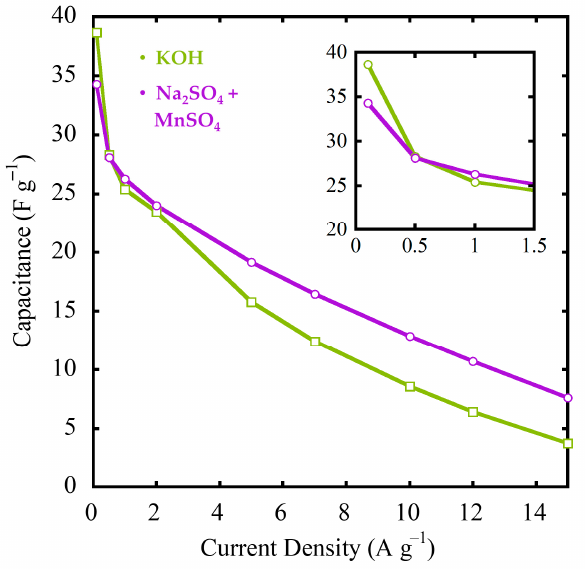
Figure 9. Comparison of the capacitances of the final systems calculated from GA charge/discharge curves shown at Figure 7 for both electrolytes.